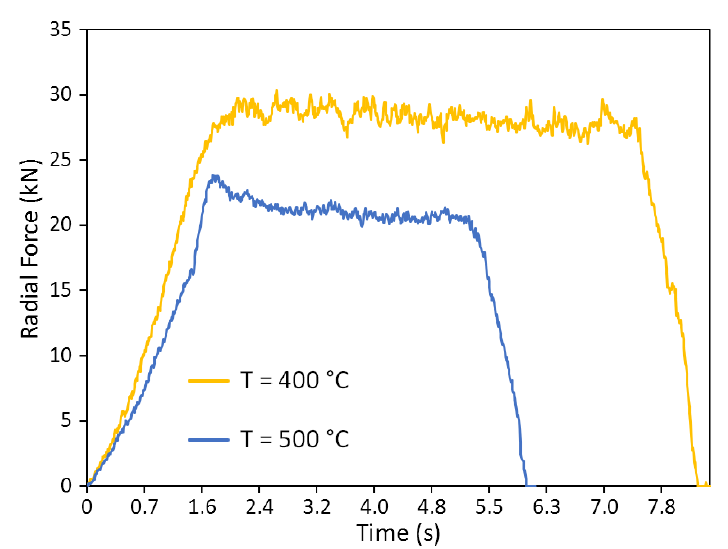
Figure 5. The diagram of change in the radial force on roll at different rolling temperatures.